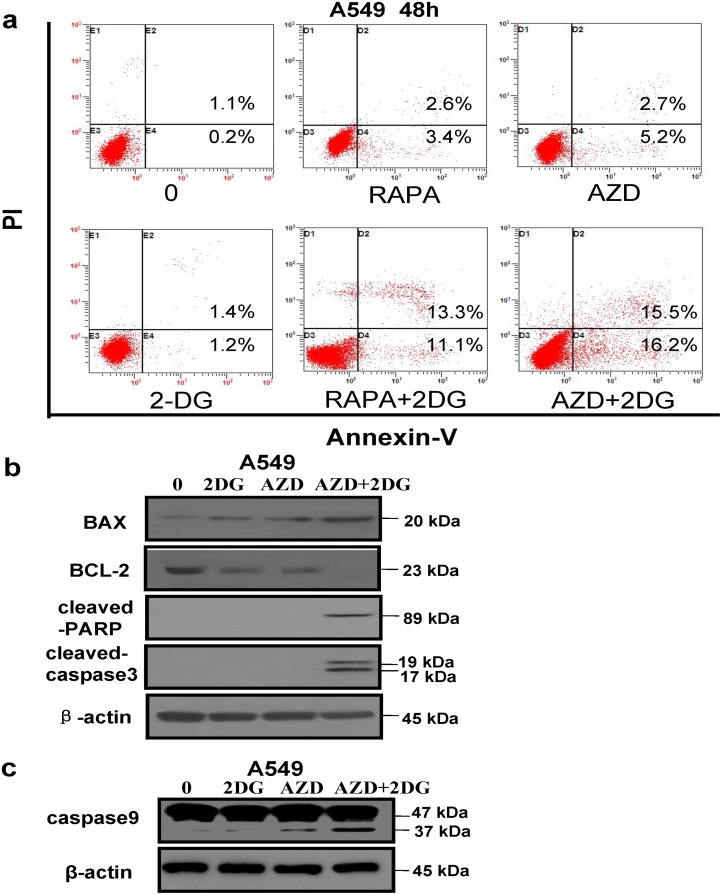
mTOR inhibitors combined with glycolysis inhibitor induced apoptosis in lung cancer cells.(a) A549 cells were pretreated with 5 mM 2DG for 1 h, and then cells were treated with 8 μM rapamycin or 5 μM AZD2014 for additional 48 h respectively, cell apoptosis was then examined by using an Annexin V-FITC/PI staining assay kit. (b) A549 cells were pretreated with 5 mM 2DG for 1 h, and then treated with 5 μM AZD2014 for additional 48 h, as well as the cells were untreated and treated with 5 mM 2-DG or 5 μM AZD2014 alone for 48 h before harvesting cellular proteins. (c) A549 cells were pretreated with 5 mM 2DG for 1 h, and then treated with 5 μM AZD2014 for additional 48 h. Meanwhile, the cells were untreated and treated with 5 mM 2DG or 5 μM AZD2014 alone for 48 h before harvesting cellular proteins. All cell lysates were probed for the apoptosis–associated proteins such as BAX, BCL-2, cleaved PARP, cleaved caspase-3 and caspase 9 by Western blotting. The similar results were obtained from other two independent experiments, and data shown are the representatives of the three experiments.